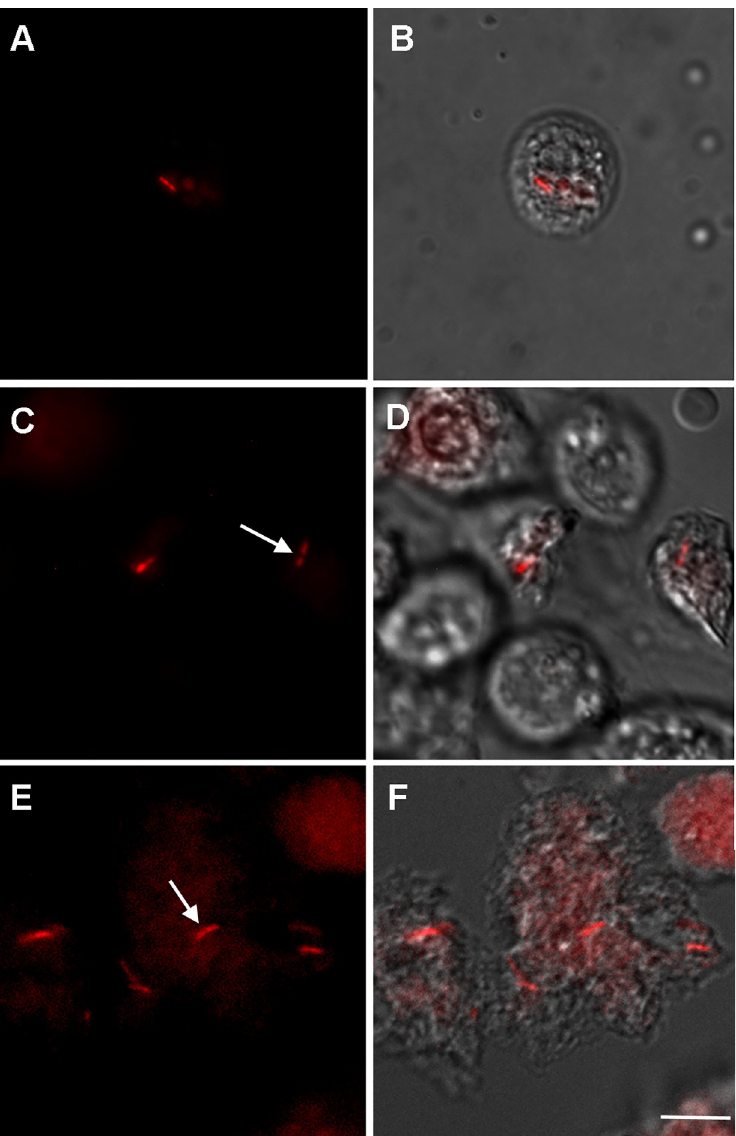
Fig 8. Fluorescent Mycobacterium leprae generated by transfection with the plasmid pCHERRY3 within IDE8 tick cells. Fluorescence of the bacteria expressing mCherry was seen after 1 week (A, B), 2 weeks (C, D) and 2 months (E, F) after transformation; at all time points, the majority of fluorescent M . leprae -mCherry were in division (arrows). Panels A, C and E were generated by conventional fluorescence microscopy, using a 590 nm LED with a Zeiss fluorescence filter 61; panels B, D and F were generated by merging with differential interference contrast images. Scale bar represents 10